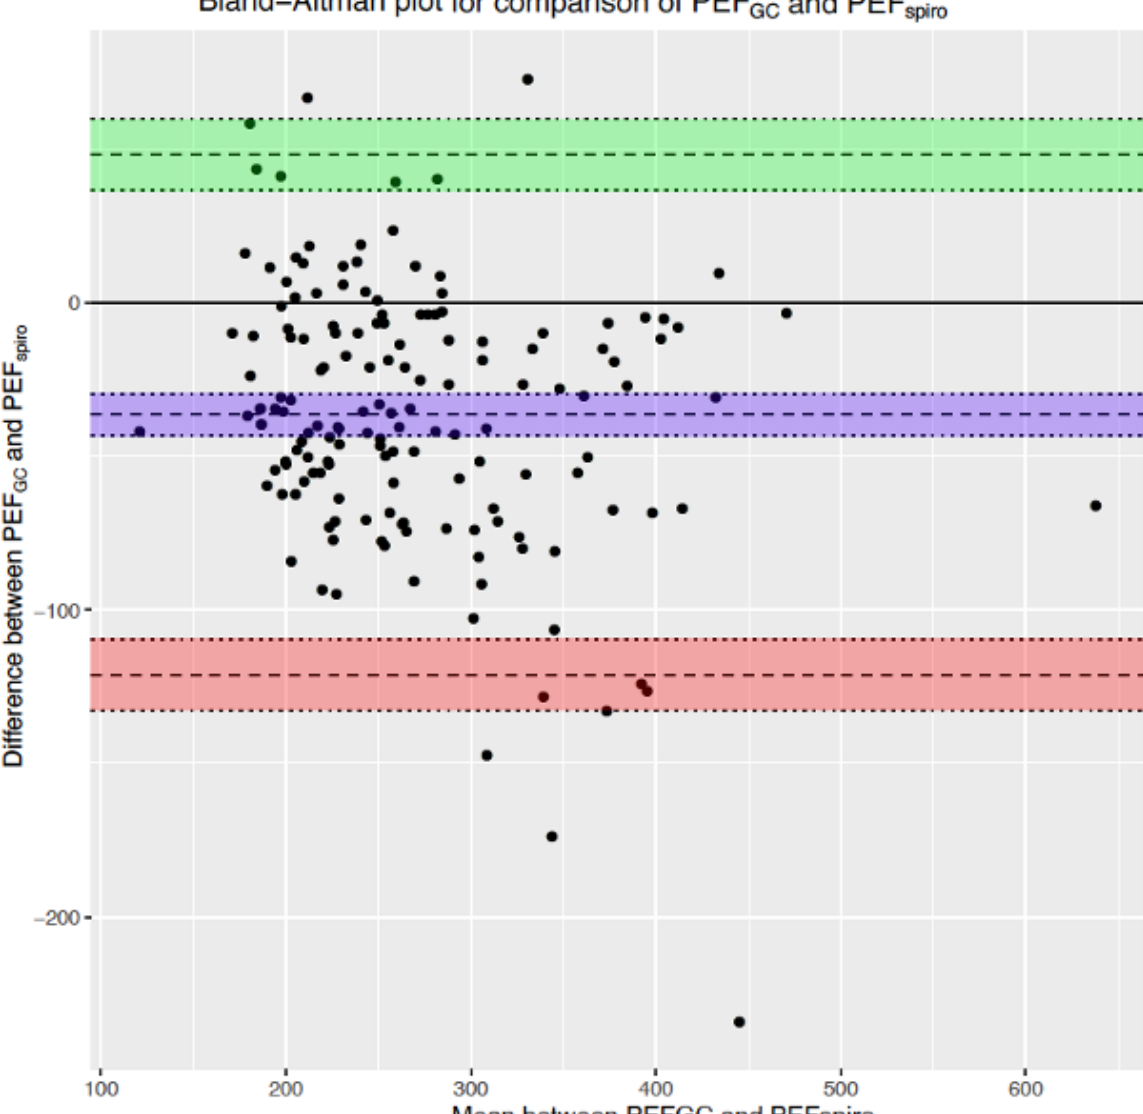
Figure 3. Bland-Altman plot comparing the game controller and conventional spirometry for PEF measurements. The game controller presents a mean bias of –36.4 L/min (blue; 95% CI –43.2 to –29.6) with a 95% upper limit of agreement of 48.3 (green; 95% CI 36.6 to 60.0) and a 95% lower limit of agreement of –121.0 (red; 95% CI –132.7 to –109.4) when compared to conventional spirometry. PEF: peak expiratory flow. PEF GC : peak